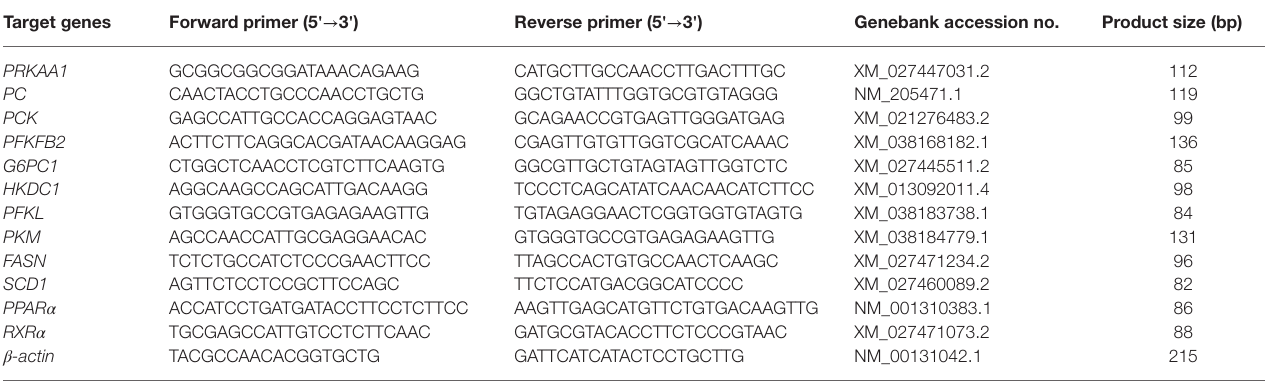
TABLE 1 | Forward and reverse primer sequences for PCR analysis. Target genes Forward primer (5 ' → 3 '